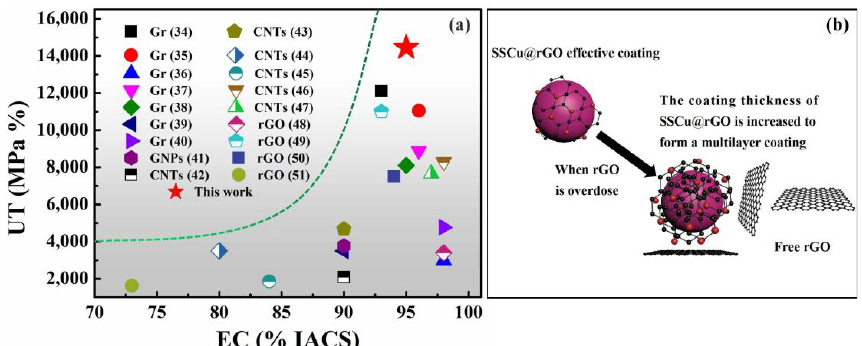
Figure 8. ( a ) Comparison of the UT and EC values of the SSCu@rGO/Cu composites prepared in this work with those of other carbon-containing CuMCs; ( b ) SSCu@rGO forms a multilayer coating, and there is residual rGO after the coating is completed.